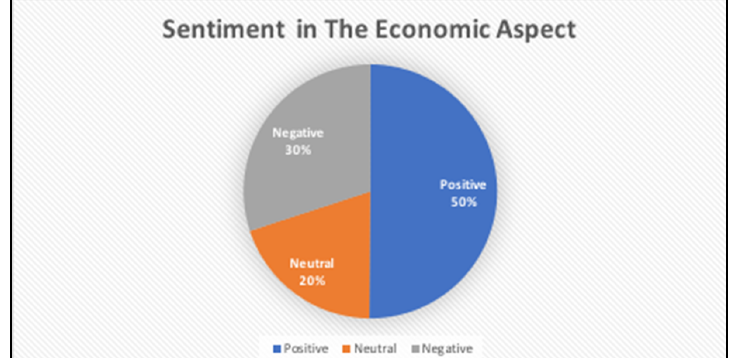
Fig. 4 The graph of sentiment in the economic